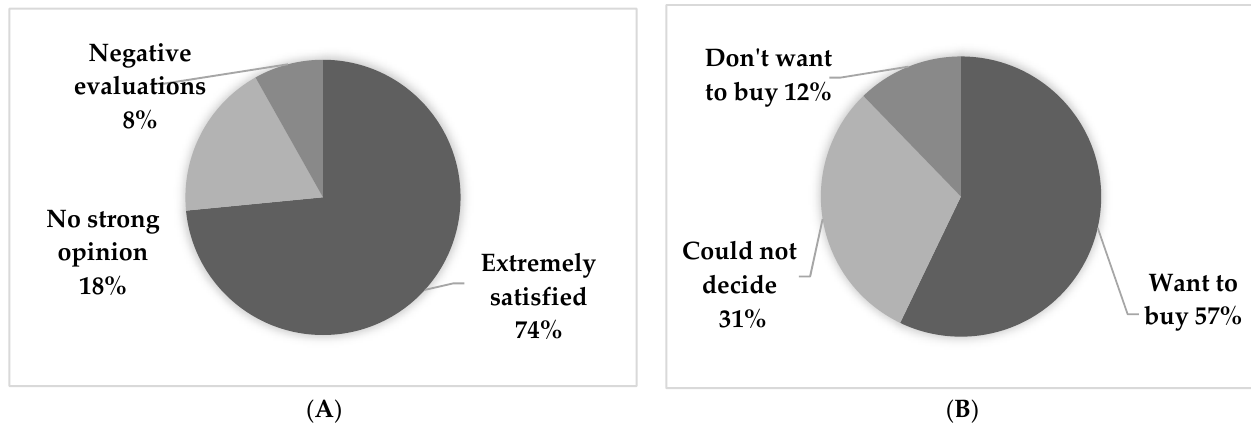
Figure 3. Impressions of participation in this study in response to questions: ( A ) How did you feel about participating in the study ; and ( B ) would you buy the lunches used in the study if they were available for sale?